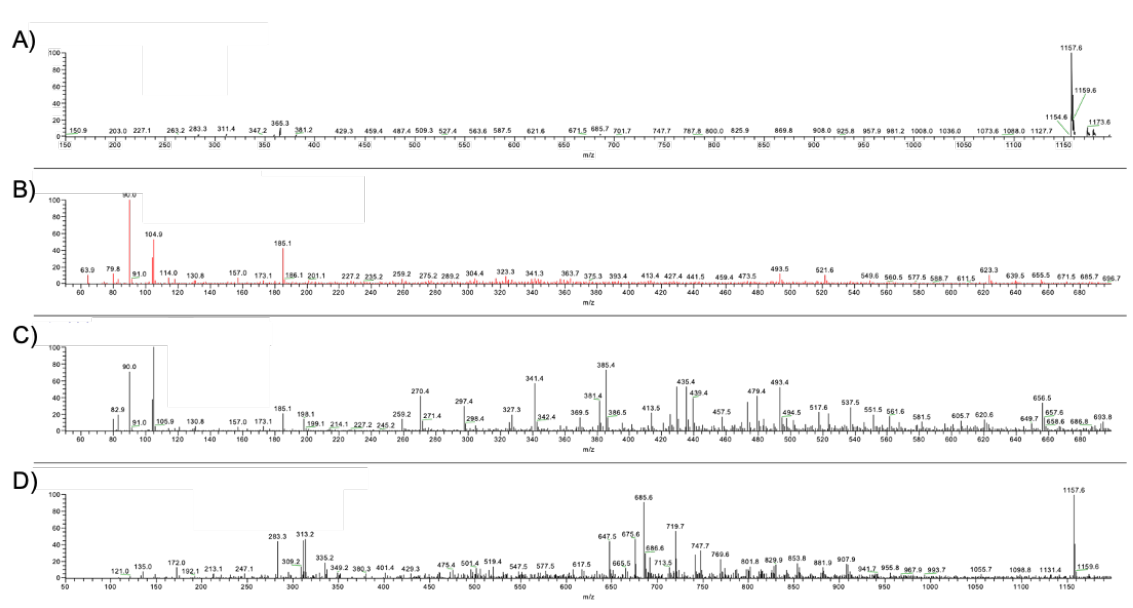
Figure 3. ESI-MS spectra of ( A ) b-CD, ( B ) T. capitatus EO b-CD, ( C ) solid-state b-CD – EO-T in the high mass range and ( D ) solid-state b-CD – EO-T in the low mass range.